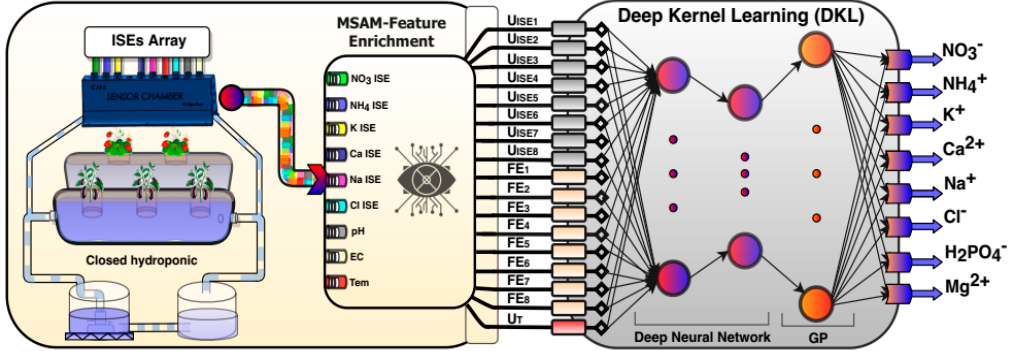
Figure 1. The novel combination of multivariate standard addition (MSAM)–feature enrichment (FE) –deep kernel learning (DKL) architecture for determining multi-ions in hydroponic solutions.